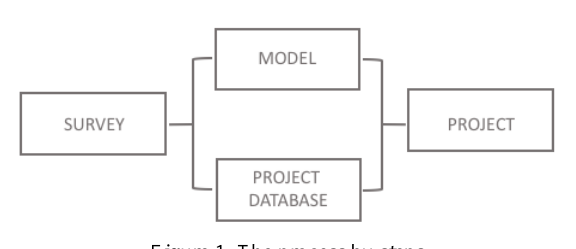
Figure 1. The process by steps